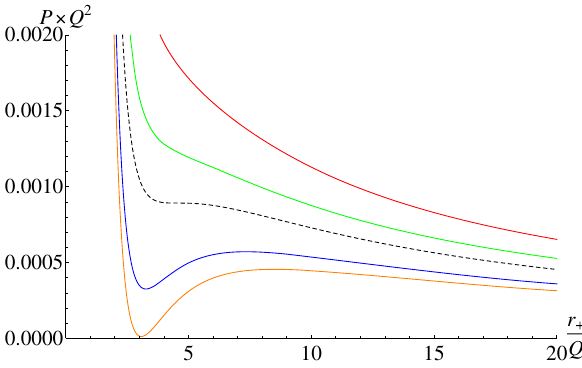
Fig. 10 The P − r + diagram for various temperatures. The red, green, dashed black, blue, and organ curves correspond to T × Q = 0 . 03, 0 . 025, ≈ 0.0221 ( T c × Q ) , 0 . 0183, 0 .